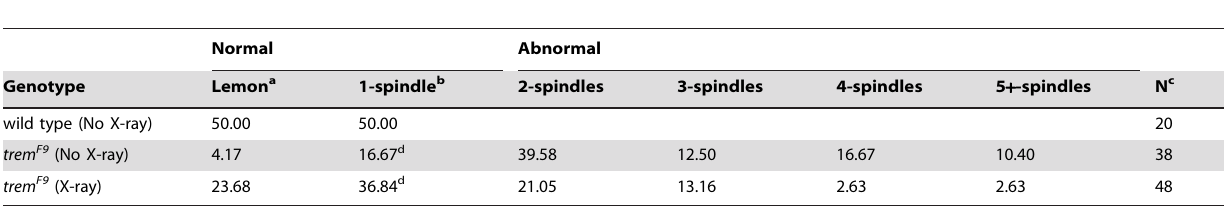
Table 7. Meiosis I spindle formation can be partially rescued in trem F9 by X-ray treatment.